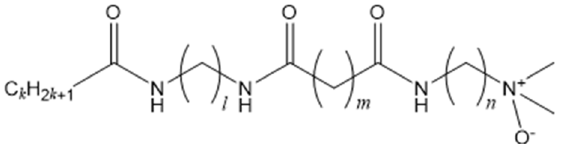
Figure 1. Chemical structure of alkyl amidoamine oxide. k is the length of the methylene chain of the hydrophobic part, l is the length of the methylene chain between nitrogen atoms of the amide groups, m is the length of the methylene chain between carbonyl groups of the amide groups, and n is the length of the methylene chain between the amide and amine oxide groups. AAO is denoted as k - l - m - n using the length of the methylene chain in four places.